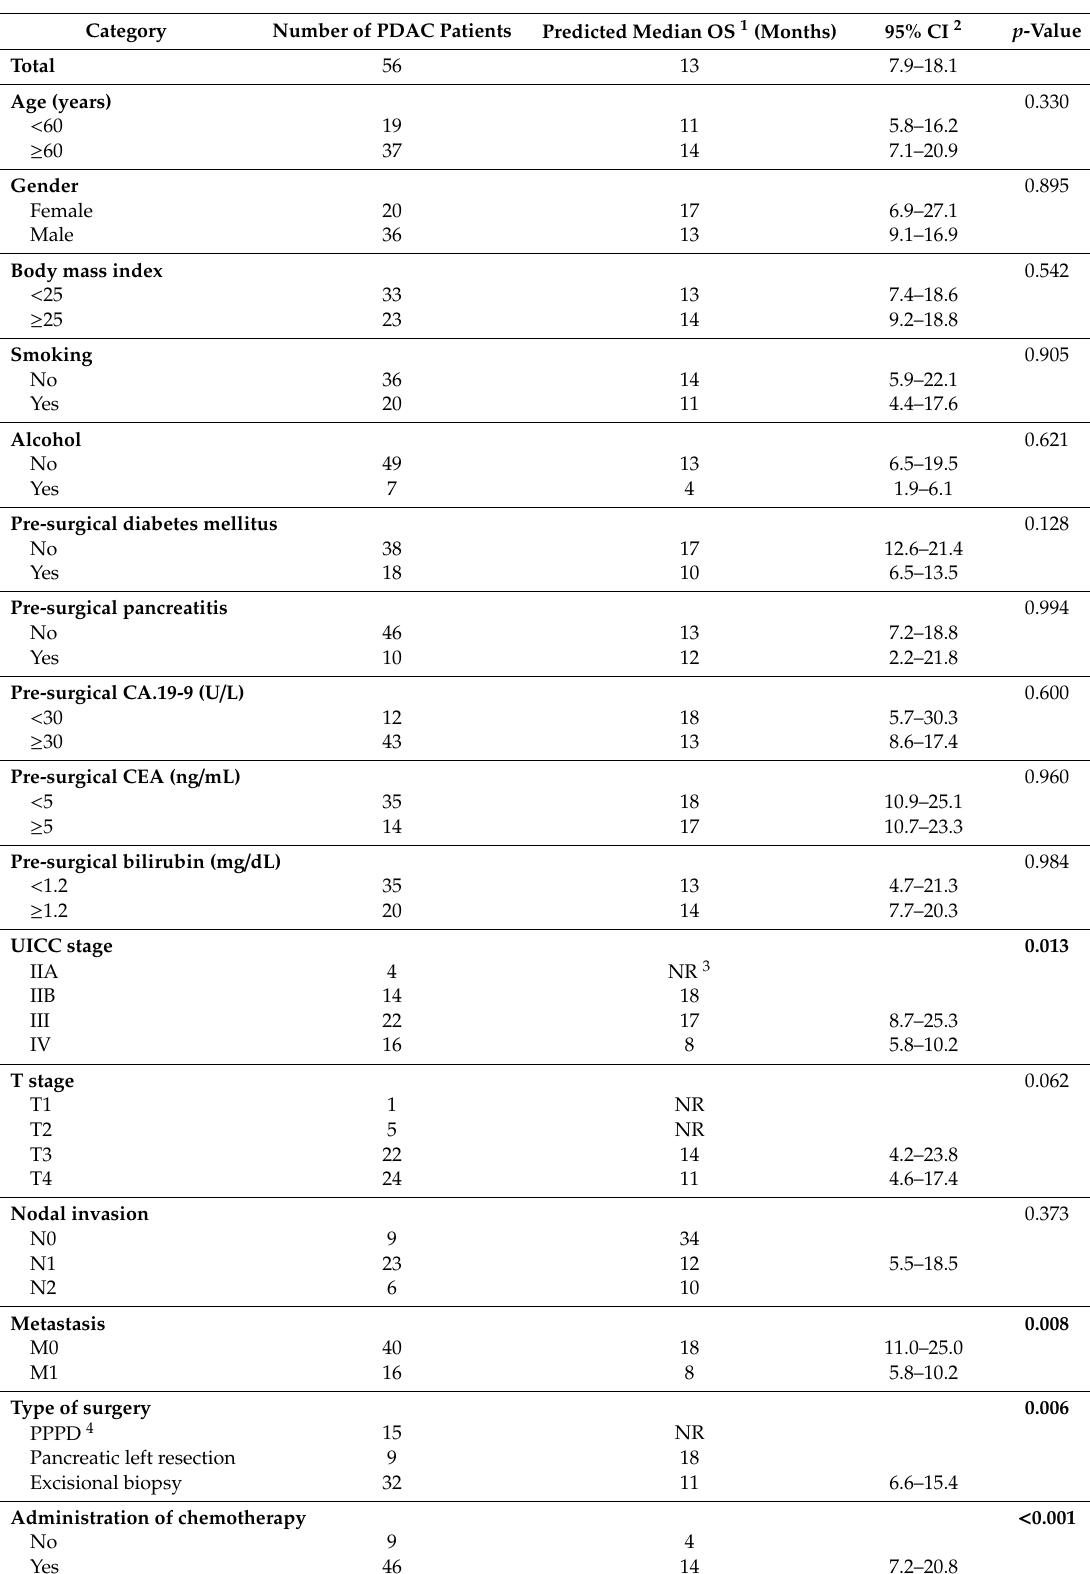
Table 2. Survival analysis of histopathologic data of patients with PDAC UICC stage II to